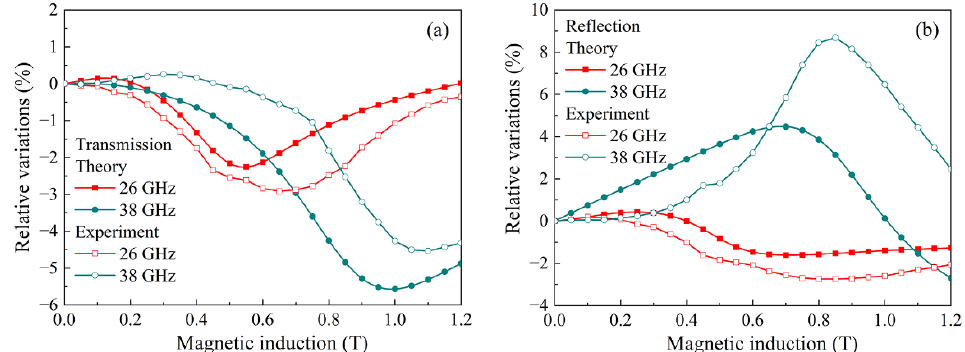
Figure 10. Comparison of theoretical and experimental dependences of the transmission coefficient ( a ) and reflection coefficient ( b ) on the magnetic field for a composite with 3.8% flakes and 2% CNT.